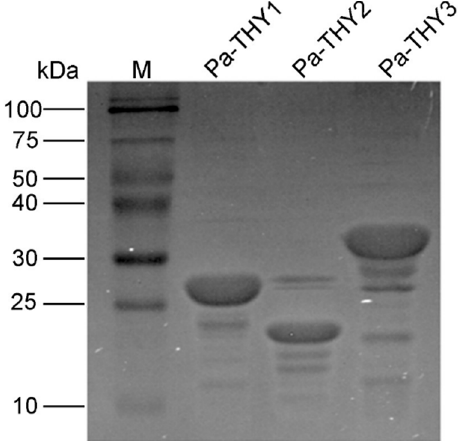
Figure 3. The purification of recombinant protein Pa-THYs: lane 1, marker (M) proteins and their corresponding molecular masses; lane 2, the concentrated Pa-THY1 protein; lane 3, the concentrated Pa-THY2 protein; lane 4, the concentrated Pa-THY3 protein. Int. J. Mol. Sci. 2019 , 20 , x FOR PEER REVIEW